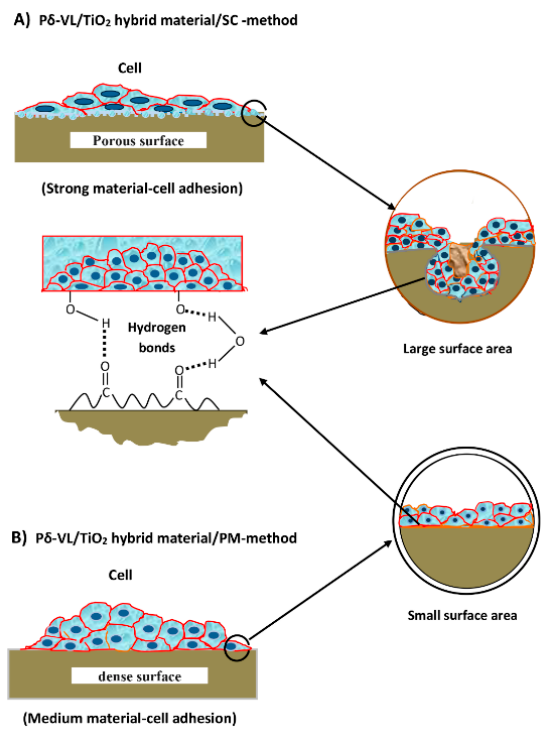
Figure 4. Cell adhesion screening tests performed with virgin P δ -VL and TiO 2 /P δ -VL/TiO 2 hybrid materials with different TiO 2 contents prepared by SC and PM routes.